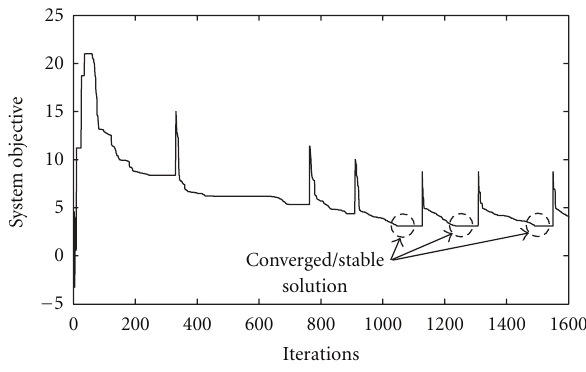
Figure 4: Convergence of the objective function for Case 1.